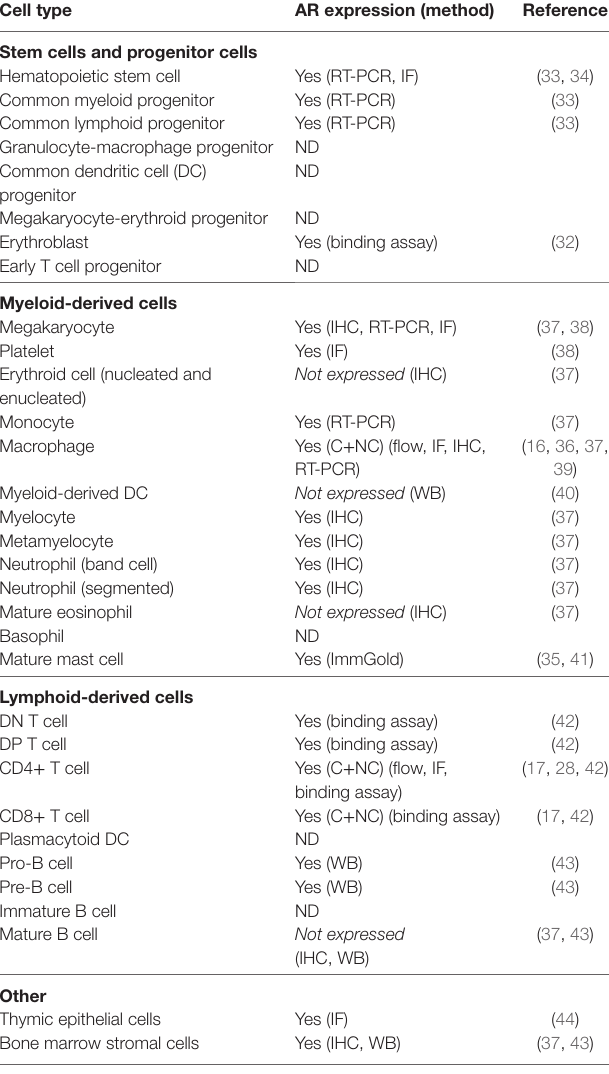
TAble 1 | Expression of androgen receptor (AR) in hematopoietic